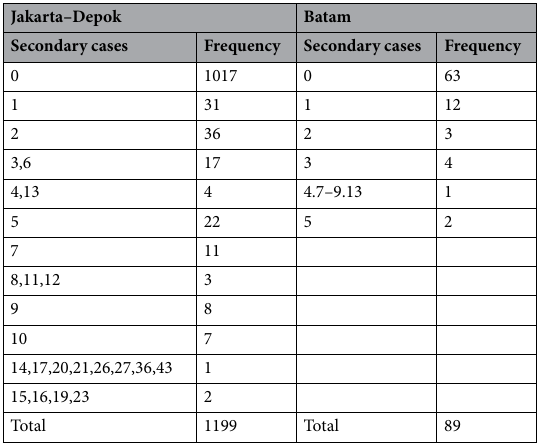
Table 1. Secondary cases data of the two regions based on local transmissions.